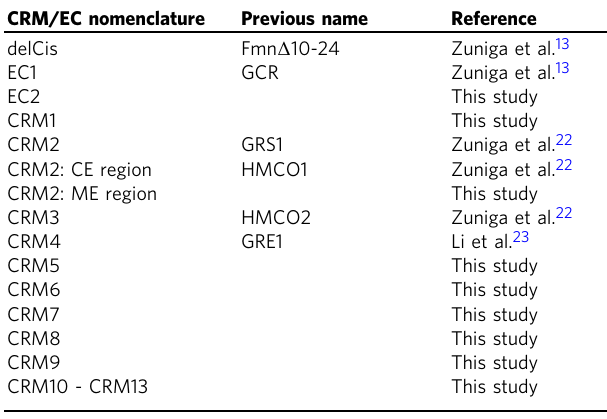
Table 1 Nomenclature of the cis -regulatory regions in the mouse Grem1 genomic